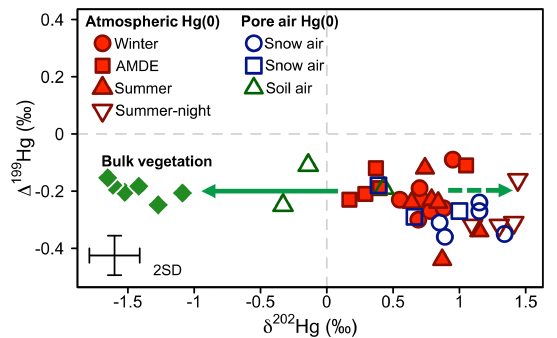
Figure 8. Overview of the mass-independent Hg isotope sig- nature ( (cid:49) 199 Hg) against the mass-dependent Hg isotope signa- ture ( δ 202 Hg) of atmospheric Hg(0) (red) and Hg(0) in the pore air of snow (blue) and soil (green) during winter (circles), the AMDE season (squares), and summer/fall (triangles). Bulk vege- tation measurements (green diamonds) are reproduced from Obrist et al. (2017). The straight arrow represents the fractionation during Hg(0) uptake by vegetation, and the dashed arrow represents the ex- pected development of the corresponding residual Hg(0) pool. Error bars represent the analytical precision determined by the 2SD from multiple measurements of an in-house